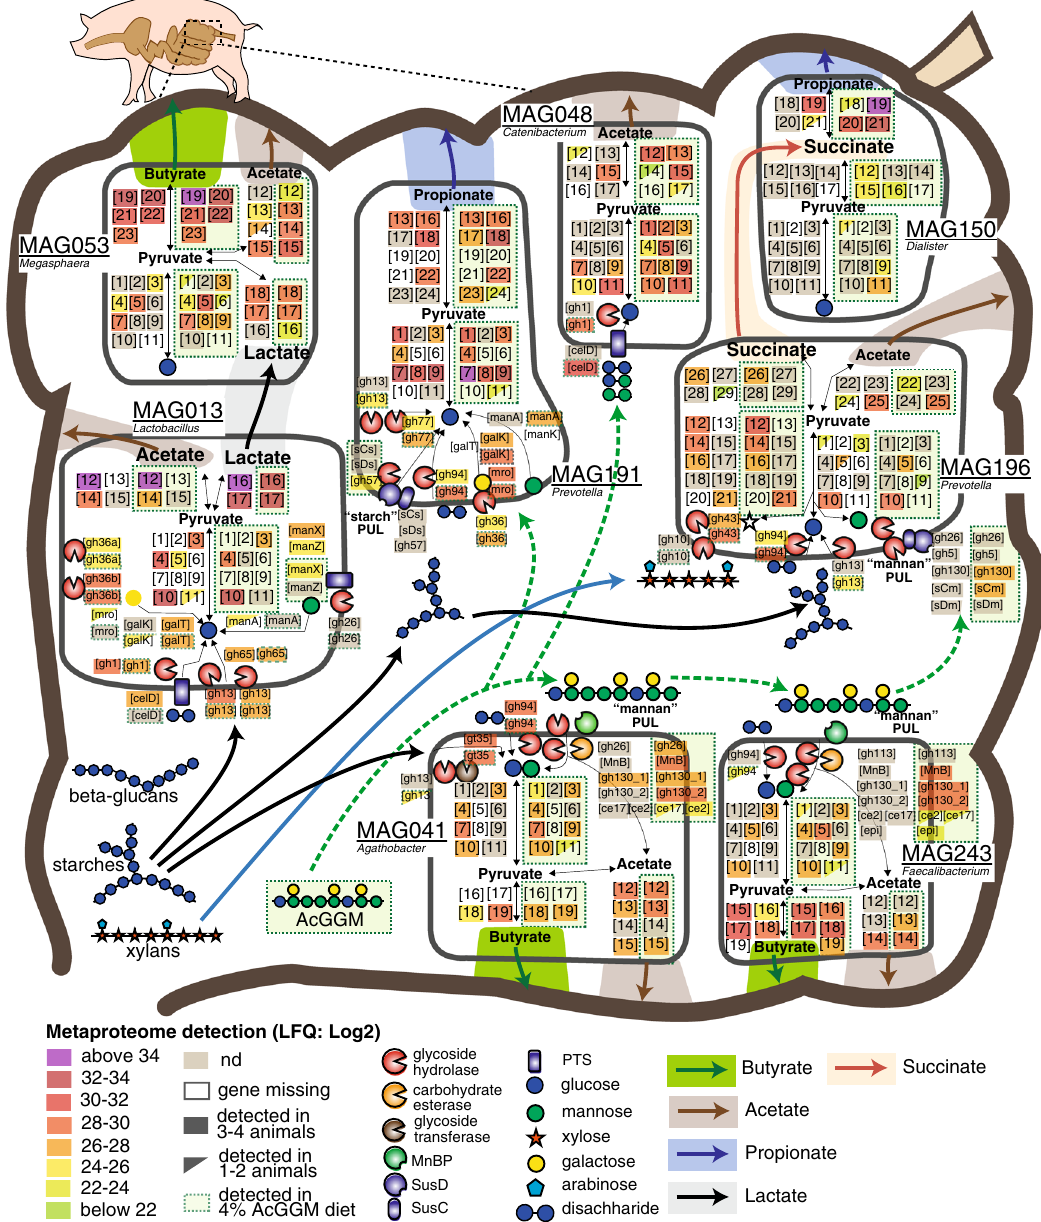
Fig. 7 Selected metabolic features of the porcine colon microbiome in response to AcGGM dietary intervention, as inferred from genome and proteome comparisons. The different metabolic pathways ( fi ber deconstruction, glycolysis, pentose-phosphate pathway, and SCFA production) are displayed for each population MAG. Graphical representation of pathways, enzymes, CAZymes, and cellular features are based on functional annotations that are depicted as numbered or abbreviated gene boxes, which are additionally listed in Supplementary Data 6. Metaproteomic analysis (detected genes and enzyme complexes) is highlighted according to the different LFQ values of the detected proteins sampled at a single time-point (28 days) either from animals fed the control or 4% AcGGM diet (green perforated boxes). The main dietary fi bers (starches, xylans, glucans, and mannans), SCFAs (butyrate, acetate, propionate), and intermediates like lactate and succinate are represented by large colored arrows. GTBD-Tk inferred taxonomy is included (recently reclassi fi ed Roseburia species are denoted as Agathobacter). Gene names and abbreviations are also provided in Supplementary Data